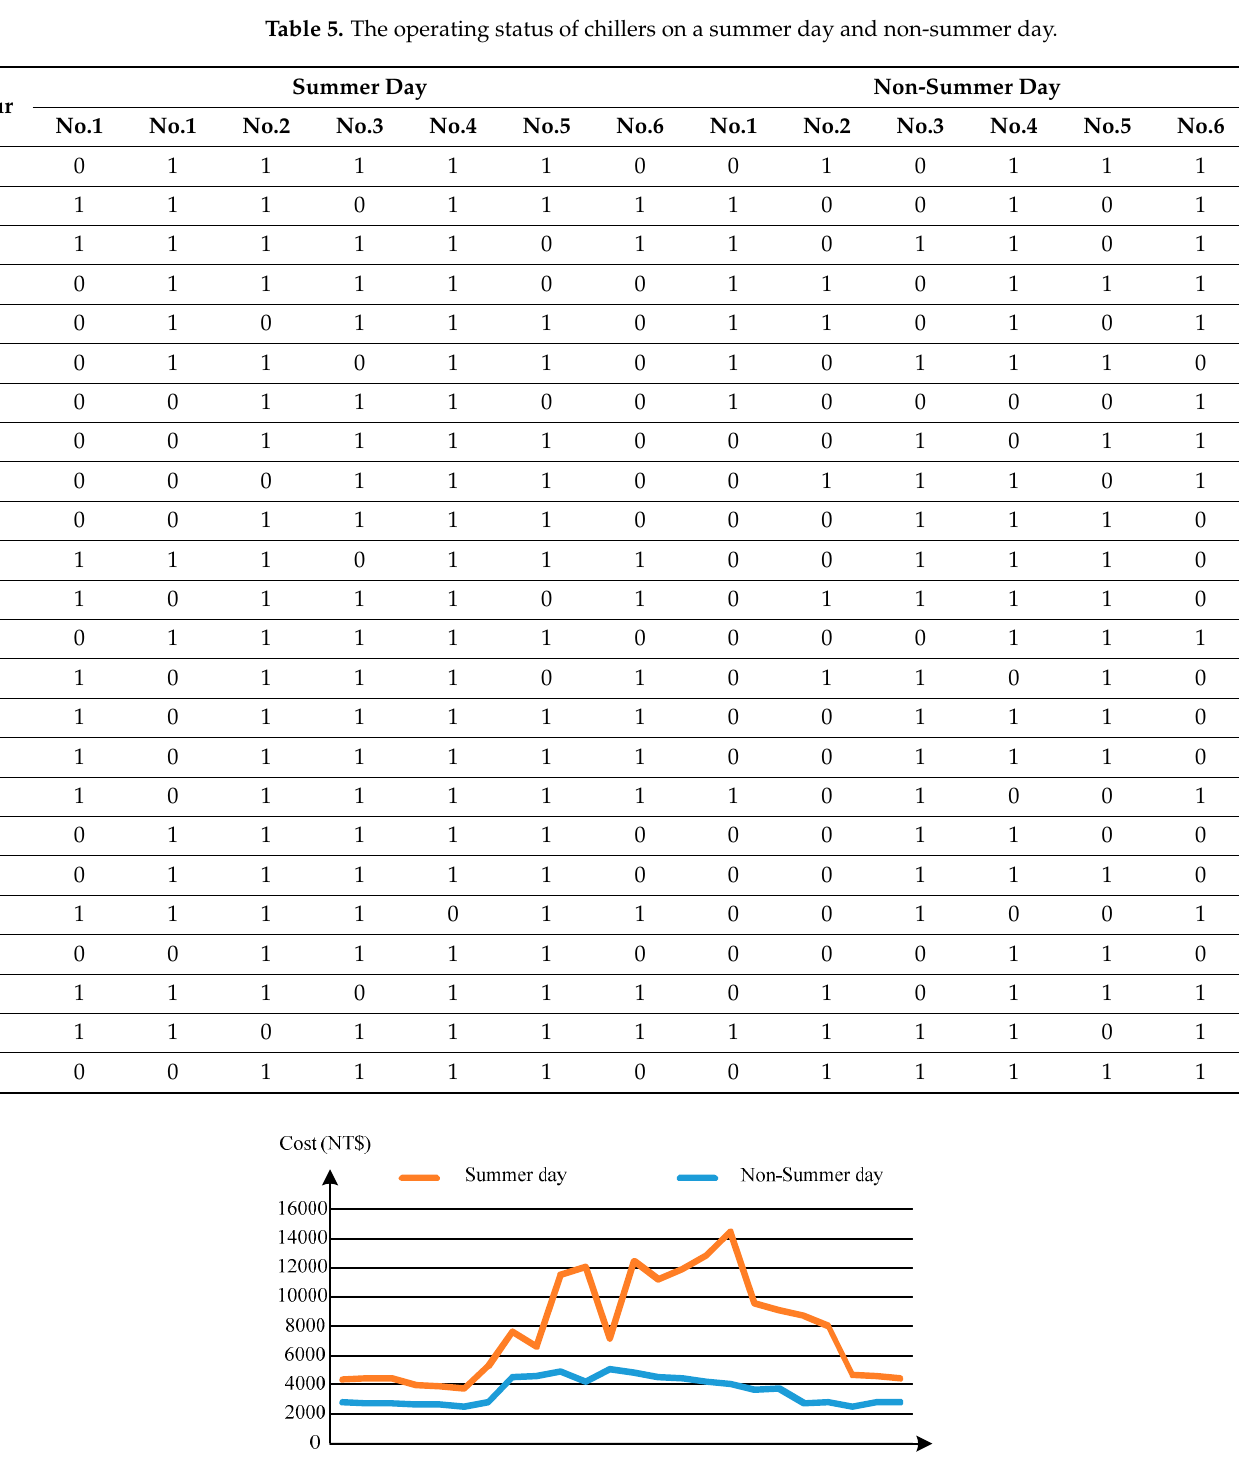
Figure 10. Convergent characteristics of operating cost on a summer day and non-summer day. Table 6 shows the comparisons of the various algorithms. An IBM PC with a P-IV2.0 GHz CPU and 512 MB SDRAM was used for this test. The improvement of the ARBFN 0